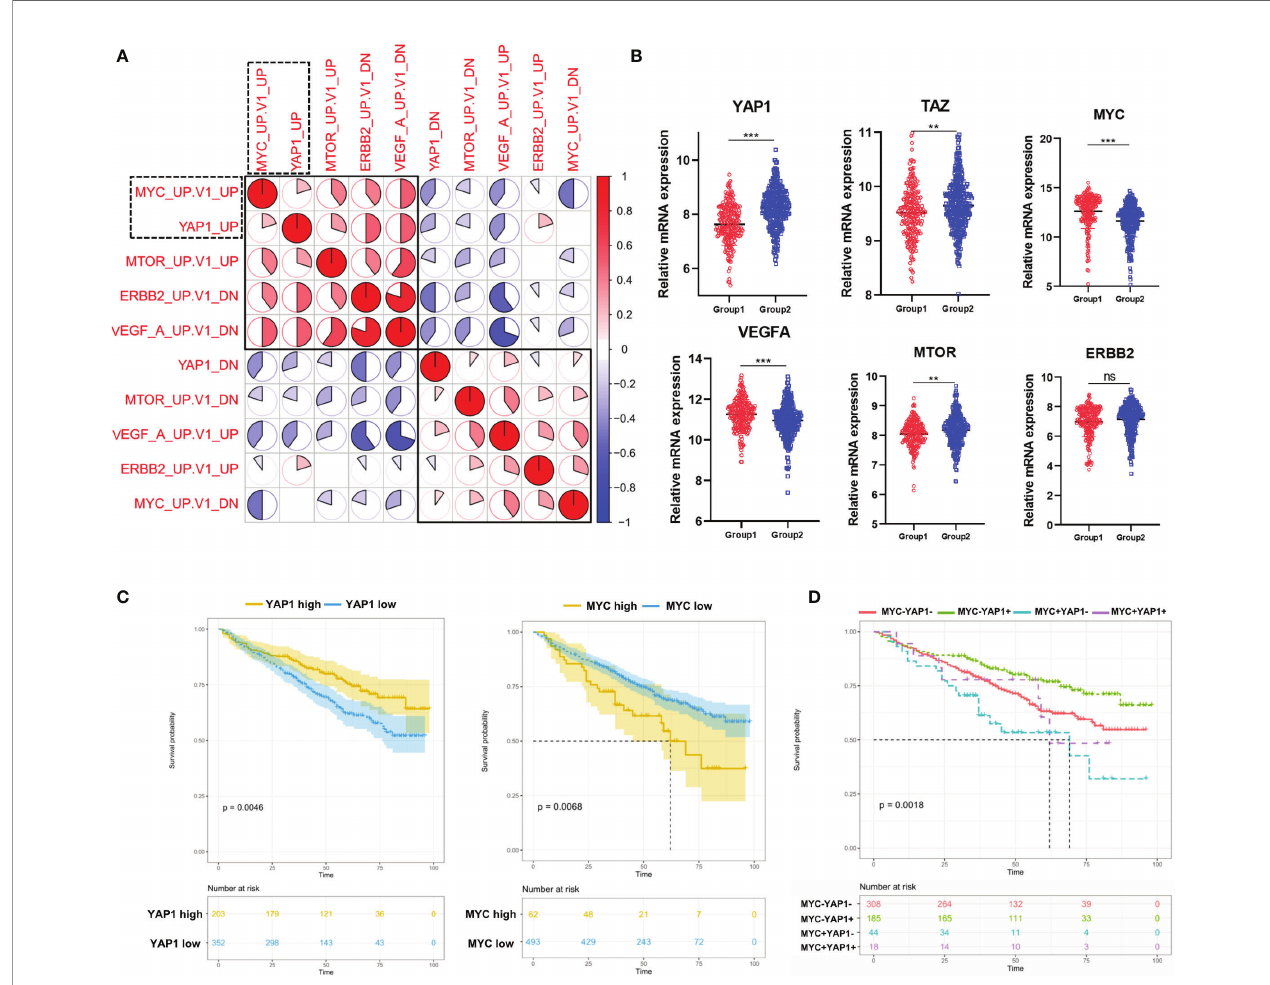
FIGURE 2 | The correlation among 5 pathways dysregulated in MM patients and their prognostic signi fi cances. (A) Heatmap of the correlation among 5 cancer- related signaling pathways using Pearson correlation coef fi cients. (B) The comparison of mRNA expression level of YAP1/MYC/MTOR/ERBB2/VEGFA/TAZ in 2 MM groups. Results are shown as mean ± SD. * p < 0.05, ** p < 0.01, *** p < 0.001, based on the Student ’ s t -test. (C) Kaplan – Meier survival curves comparing the overall survival in MM cases with high or low expression of YAP1/MYC in the GSE24080 dataset. (D) Kaplan – Meier survival curves comparing the overall survival in MM cases with differential expression levels of YAP1 and MYC in the GSE24080 dataset. ns, not signi fi